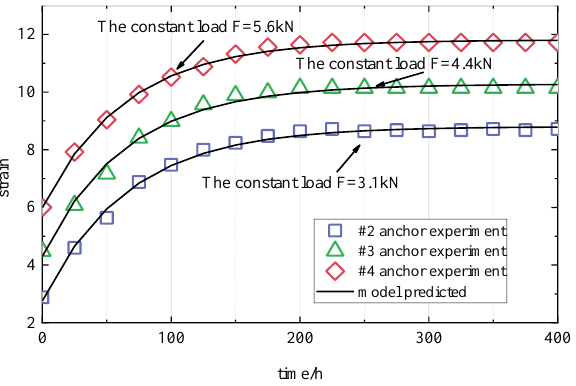
Figure 6. Soft rock test model.